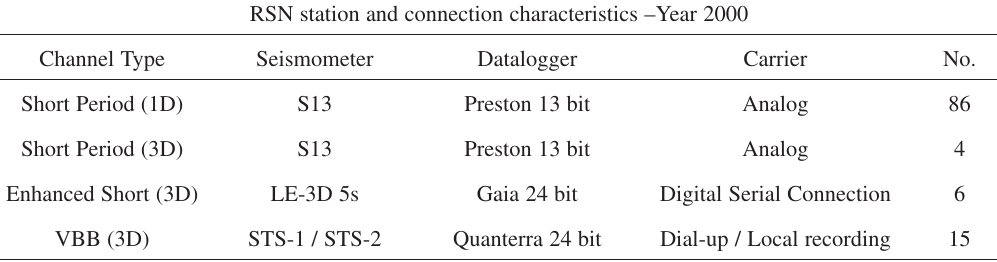
Table I. Numbers (last column) and characteristics of the RSN in year 2000, divided by sensor type (first col- umn). The total number of sensors with real-time connection to the INGV centre in Rome was 96. Fifteen Very Broad Band stations belonging to MedNet were connected with dial-up lines used to download signals when needed; a few of them were only recorded locally.